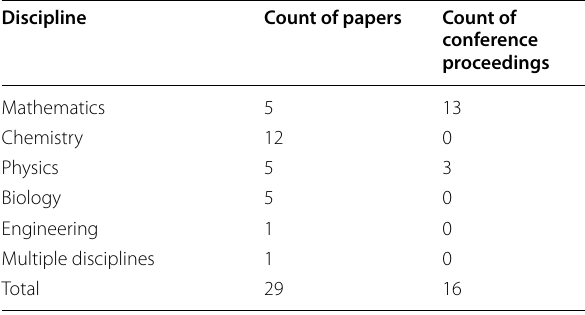
Table 2 Count of included peer-reviewed papers and peer- reviewed conference proceedings, by discipline